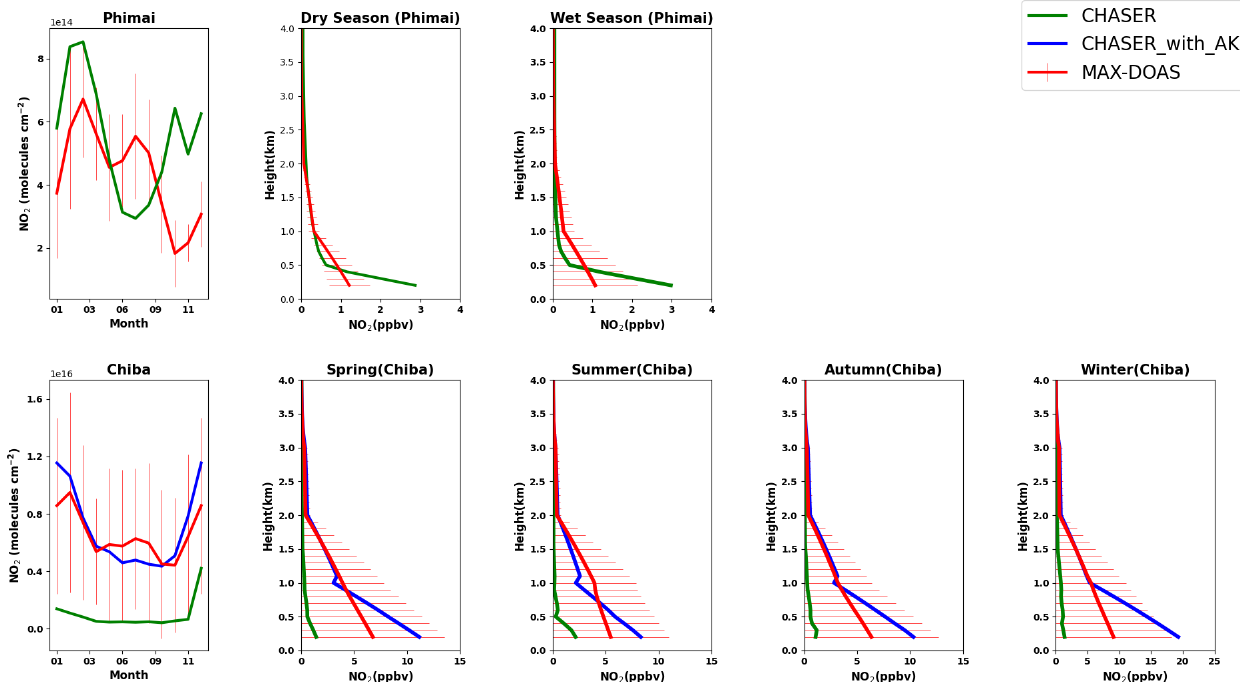
Figure 11. Seasonal variation in NO 2 partial columns from 0–4km and vertical profiles during all seasons at Phimai and Chiba, as inferred from the MAX-DOAS observations (red) and CHASER simulation (green). The CHASER NO 2 partial column and vertical profile smoothed with the MAX-DOAS AK are colored in blue. Only the coincident time and date between the model and observations are selected. The error bars represent the 1 σ standard deviation of mean values of the MAX-DOAS observations. Table 7. Comparison of the seasonal mean NO 2 partial columns and profiles (0–4km) between MAX-DOAS and CHASER at Phimai and Chiba. MBE (CHASER − MAX-DOAS) is the mean bias error. The partial-column and profile MBE units are × 10 15 moleculescm − 2 and parts per billion by volume (ppbv), respectively. Site Season Partial-column Smoothed-partial- Profile Smoothed- MBE column MBE MBE profile MBE Overall